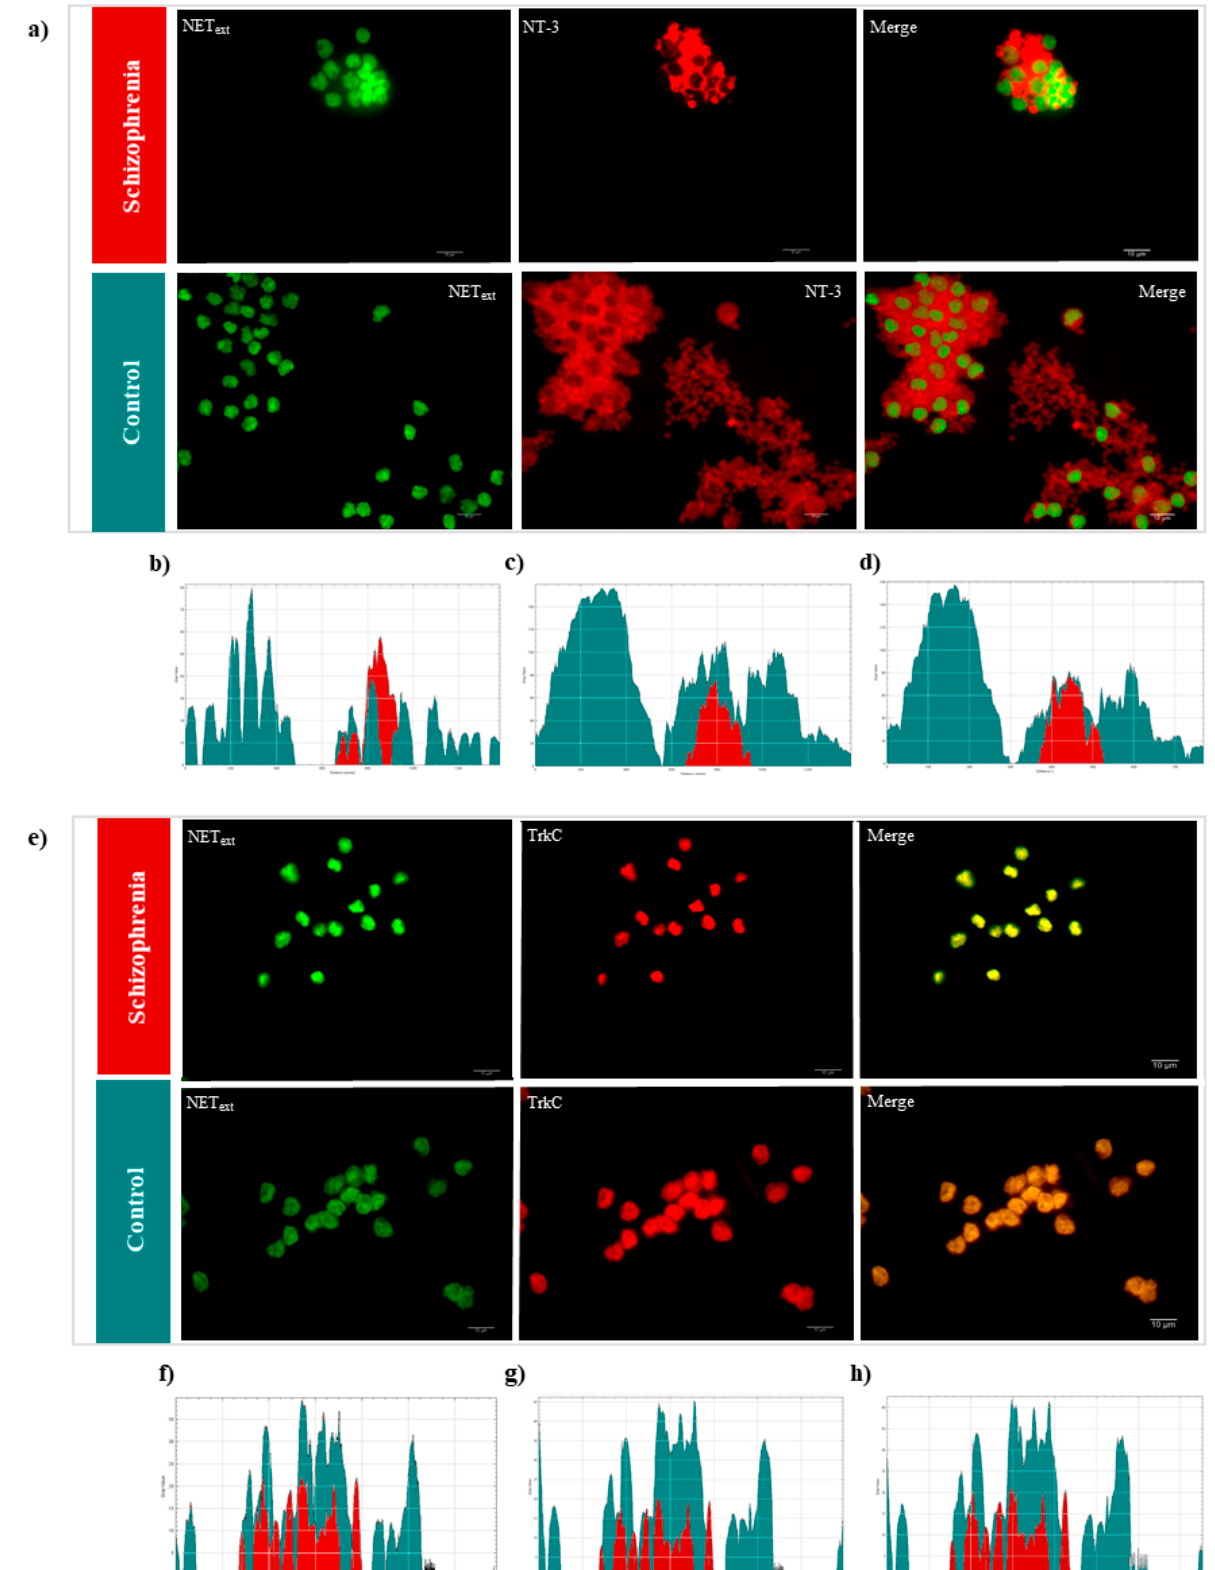
Figure 3. Fluorescence microscopy images of blood T lymphocytes. Legend: fluorescence microscopy images of blood T lymphocytes. T cells were stained with anti-NEText + anti-Alexa Fluor 488 (green color) and anti-NT-3 + anti-Alexa Fluor 594 (red color) antibodies; or anti-NEText + anti-Alexa Fluor 488 (green color) and anti-TrkC + anti-Alexa Fluor 594 (red